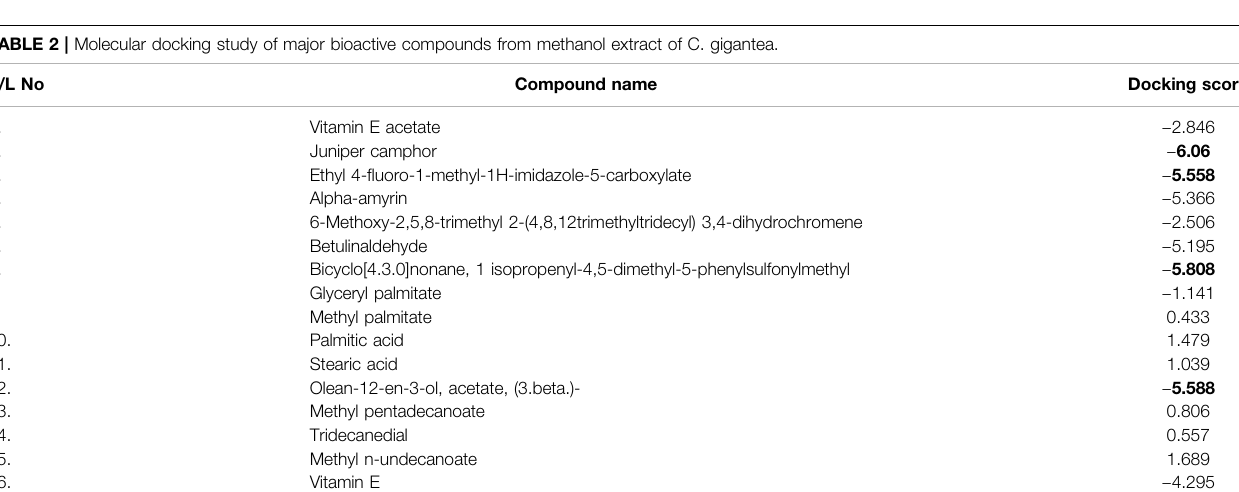
Bold text indicates the best docking